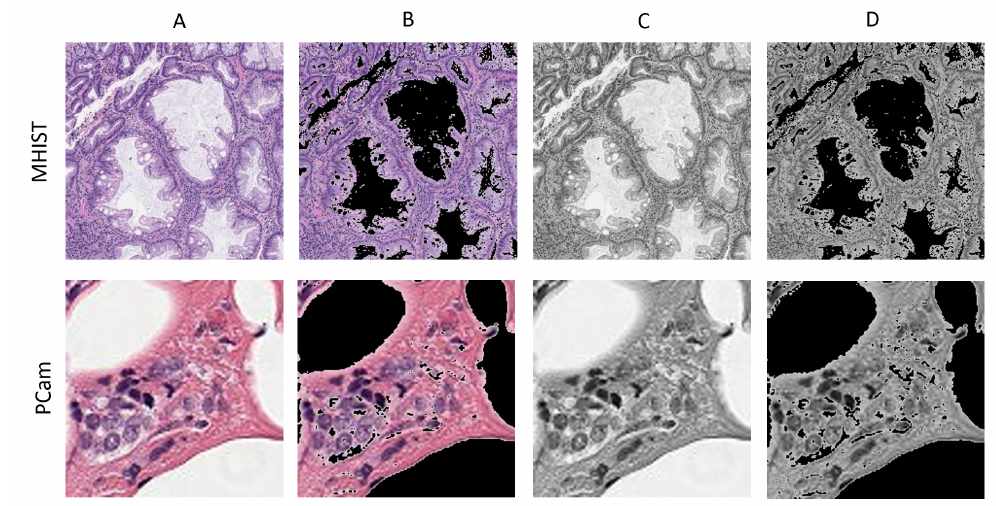
Figure 2. A sample image from the two datasets for each color mode. ( A ) RGB (original), ( B ) sparsity on RGB, ( C ) grayscale, ( D ) sparsity on